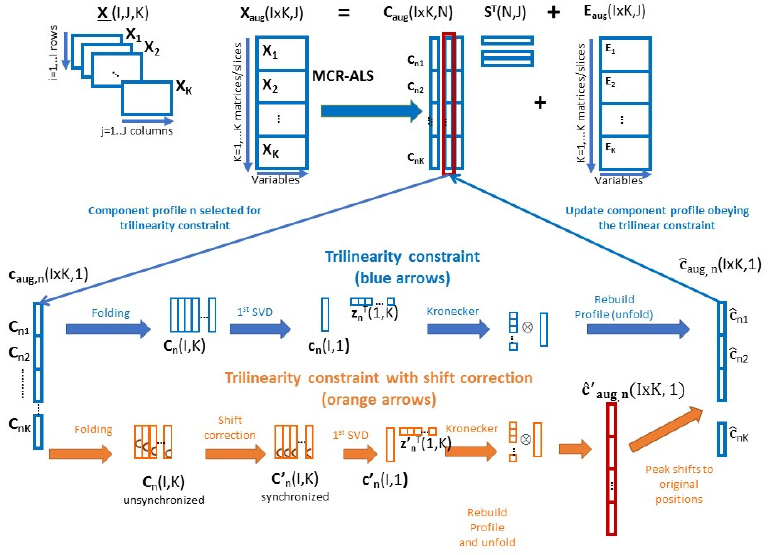
Figure 1. Implementation of the trilinearity constraint with and without synchronization in the MCR-ALS algorithm (see also Equations (4)–(6) in Section 2.2 and Appendix A). Figure 1 According to this trilinearity constraint, every augmented concentration profile in C aug (I × K, N) , for the component n, c aug, n (I × K, 1), is folded as a one component matrix C n (I × K) with I rows (number of rows in each data slice X k and C k ) and K columns (number of samples simultaneously analyzed) by setting c n1 , … , c nk individual concentra- tion profiles of this component in the different slices one besides the other. This C n (I, K) one component concentration profiles matrix is then analyzed by singular value decom- position (SVD). Only the first component is considered in the decomposition giving the common concentration profile c n (I, 1) and the K samples profile z T (1, K), Both vectors are then multiplied using their Kronecker product [51], which recalculates the long one com- ponent concentration profile 𝐜̂ aug,n (I × K, 1), which fulfilled the required trilinear model requirements of equal shape and synchronization of the 𝐜̂ n1 , … , 𝐜̂ nk individual concentra- tion profiles. When this is performed for all the components, n = 1, …, N, the C aug (I × K, N) is updated and the ALS iteration proceeds. The clear advantage of this implementation